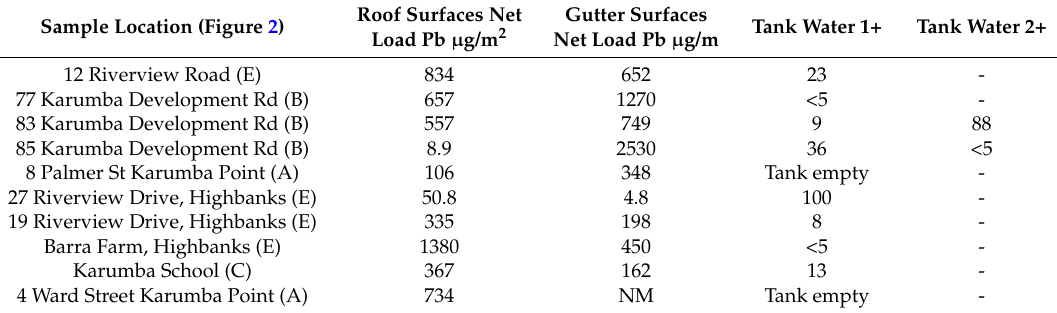
Table 1. Comparison of net Pb loadings on roof surfaces with total lead concentrations measured in rainwater tanks at sampling